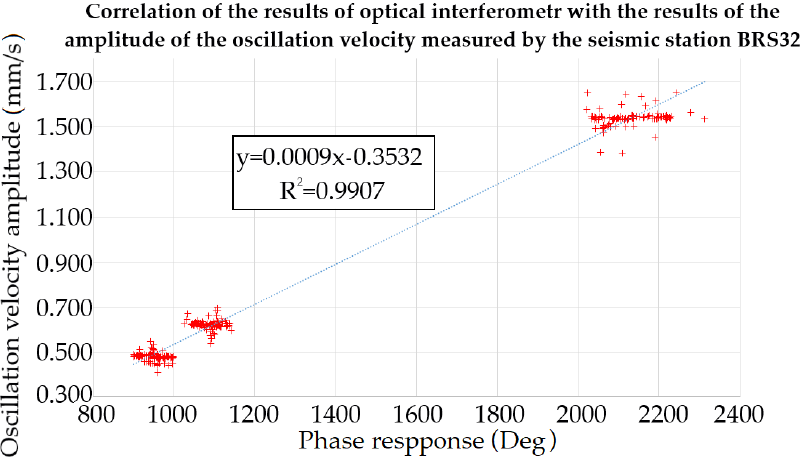
Figure 11. Mathematical relationship for the optical interferometer.